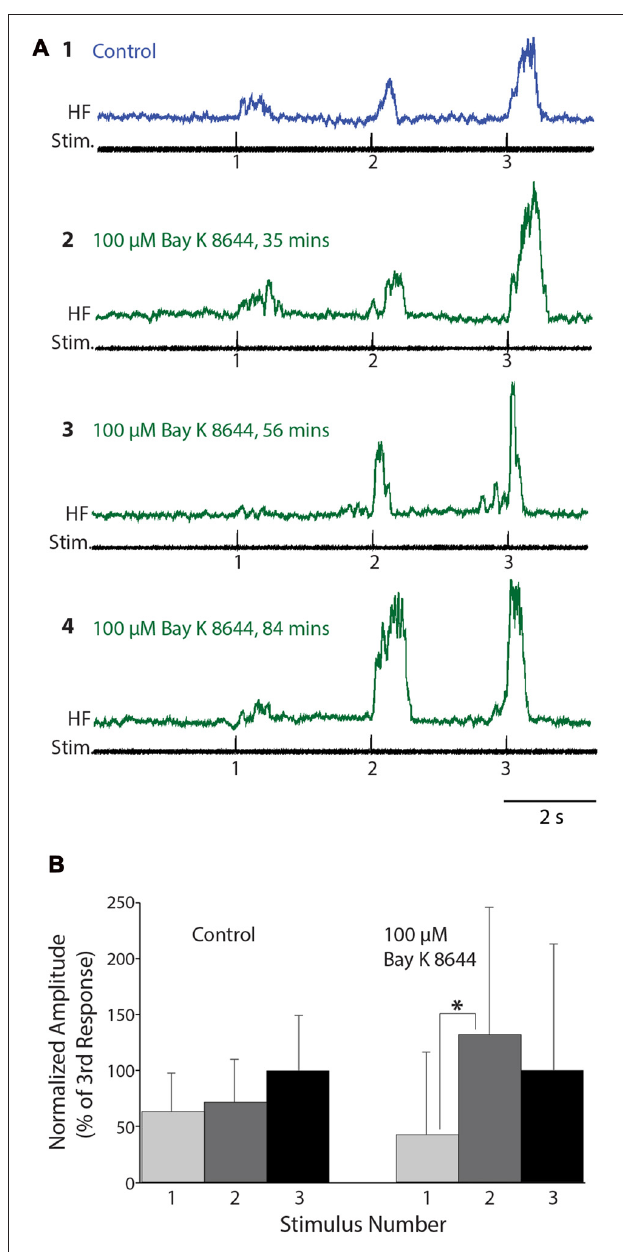
FIGURE 6 | Flexion reflex windup before and during 100 µ M Bay K 8644 application to the spinal cord. (A) Example flexion reflex responses in control saline (1) and 100 µ M Bay K 8644 (2–4) using electrically evoked flexion reflex and 3-s intervals. (B) Mean flexion reflex amplitude (normalized to the mean response to the 3rd stimulus) in control saline and during 100 µ M Bay K 8644 application for the animal shown in (A) . Error bars are standard deviations. Asterisk indicates a statistically significant increase in mean response amplitude from the 1st to the 2nd stimulus in Bay K 8644; other differences between consecutive mean responses were not statistically significant. There were 14 control trials and 16 Bay K 8644